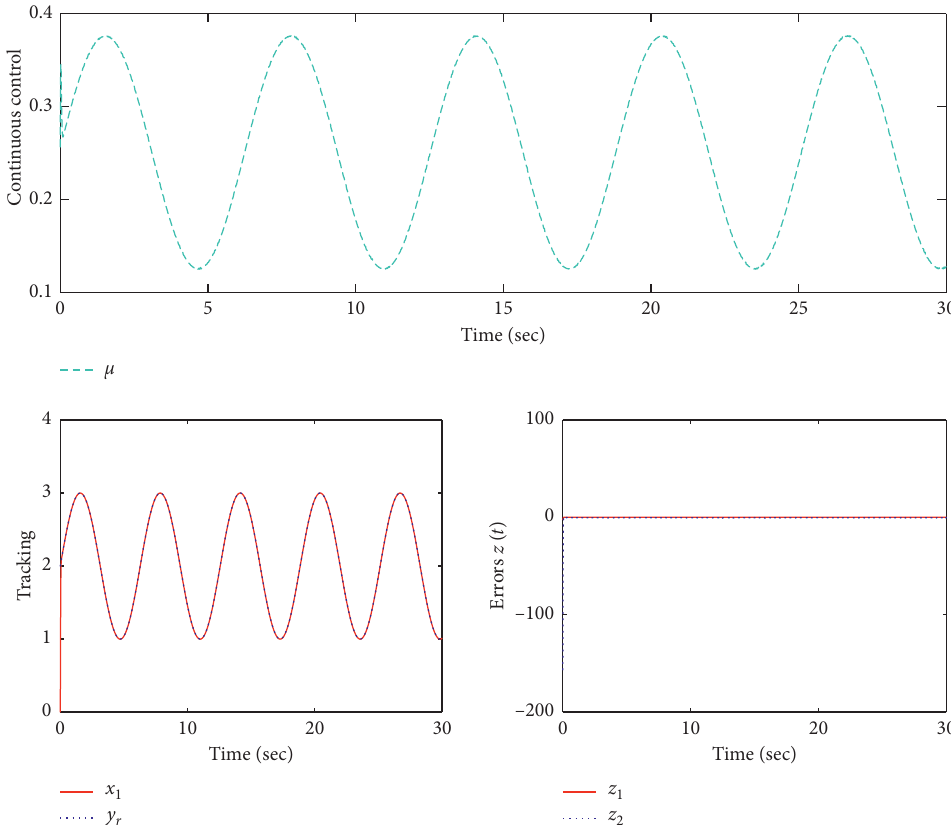
Figure 6: The response of closed-loop continuous model (25) with equivalent continuous control